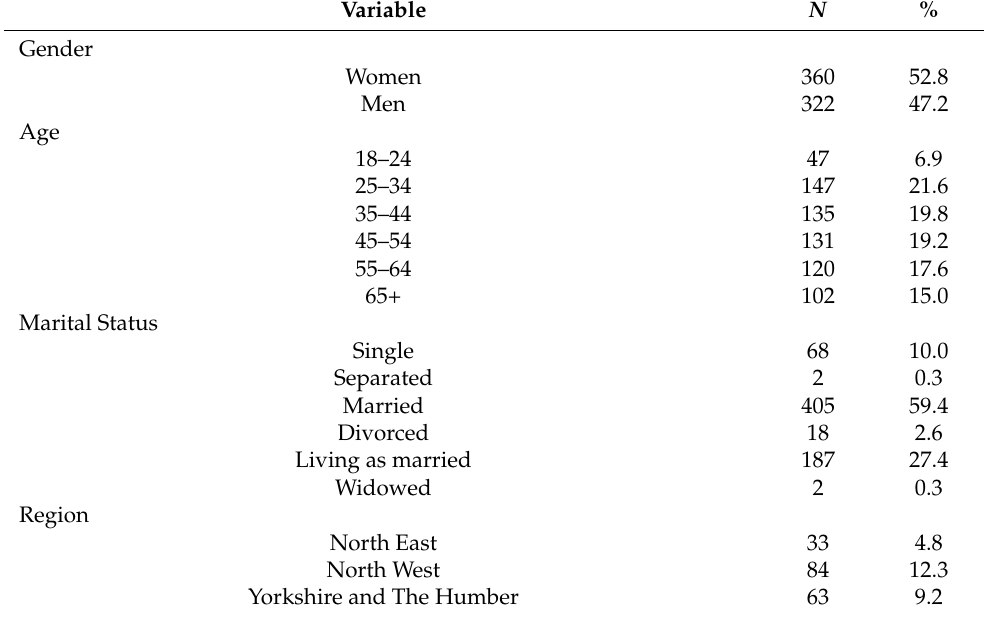
Table 1. Study sample characteristics ( n =